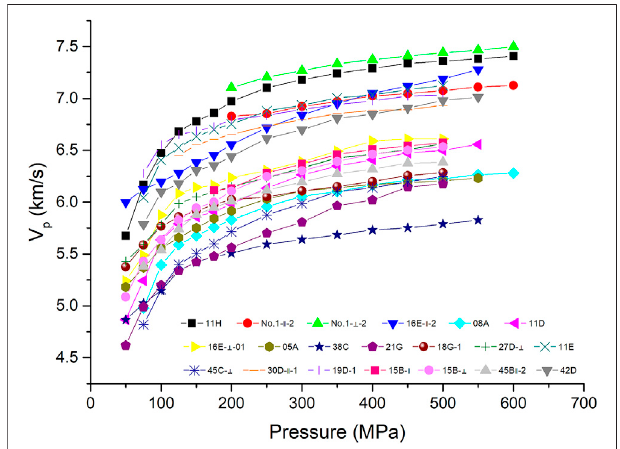
FIGURE 3 | Pressure dependence of the P-wave velocities, where (cid:1) indicates thewavevelocityparallel tothefoliation direction and ⊥ indicates the wave velocity perpendicular to the foliation direction.